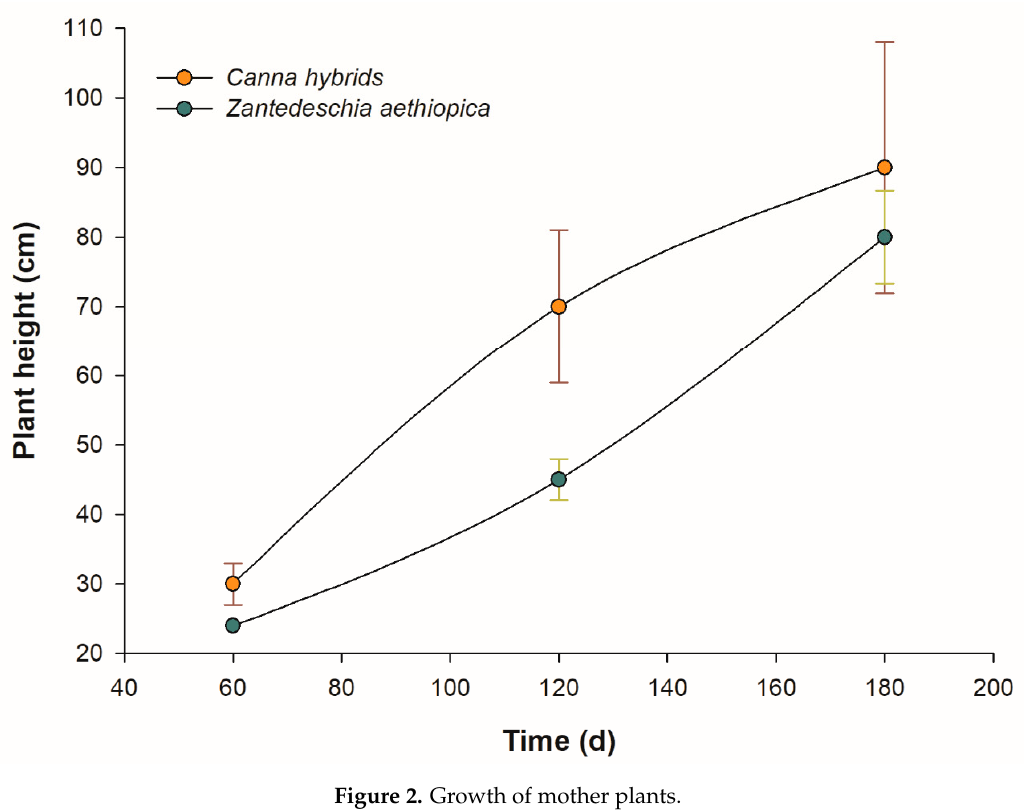
Figure 2. Growth of mother plants.